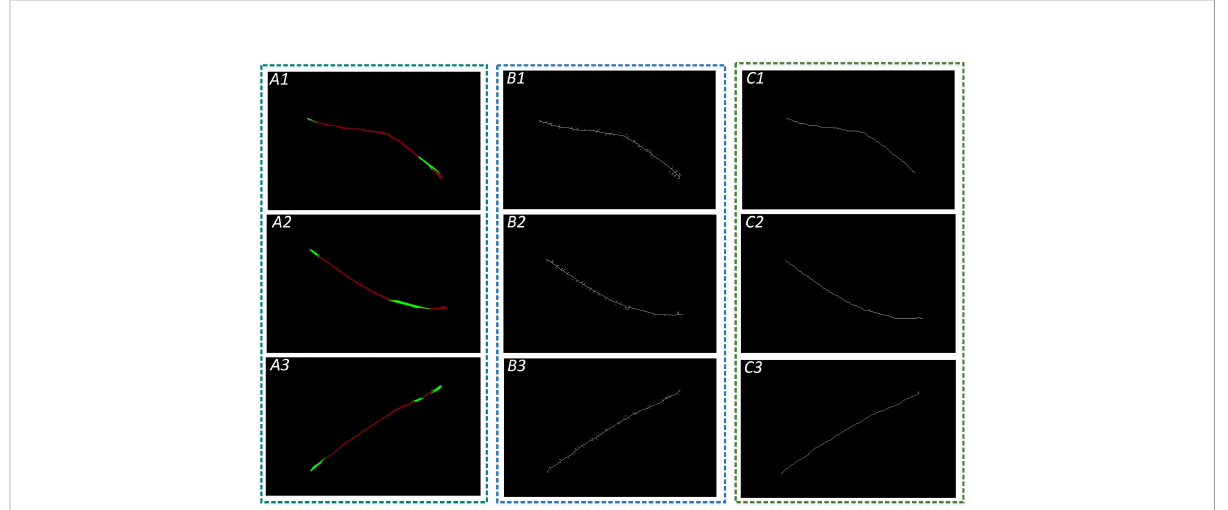
FIGURE 15 Re fi nement of leaf vein images. A1, A2, and A3 are images of restored leaf veins using the Convex Hull-Scan method; B1, B2, and B3 are leaf vein skeleton lines extracted using the Morphology Skeleton re fi nement algorithm; and C1, C2, and C3 are leaf vein skeleton lines extracted using the F-3MS